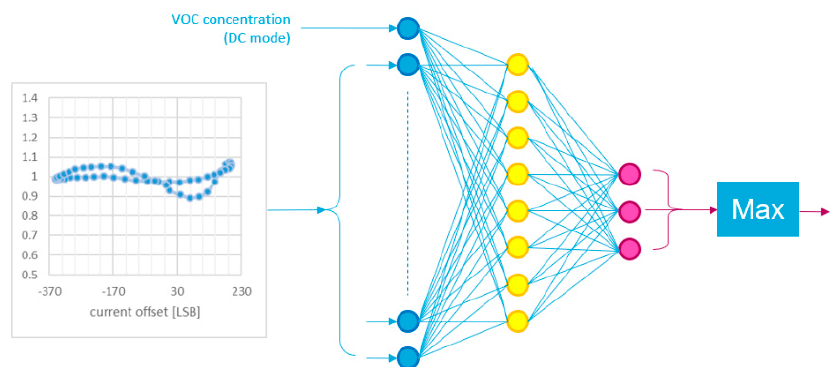
Figure 25. MLP neural network for gas identification.